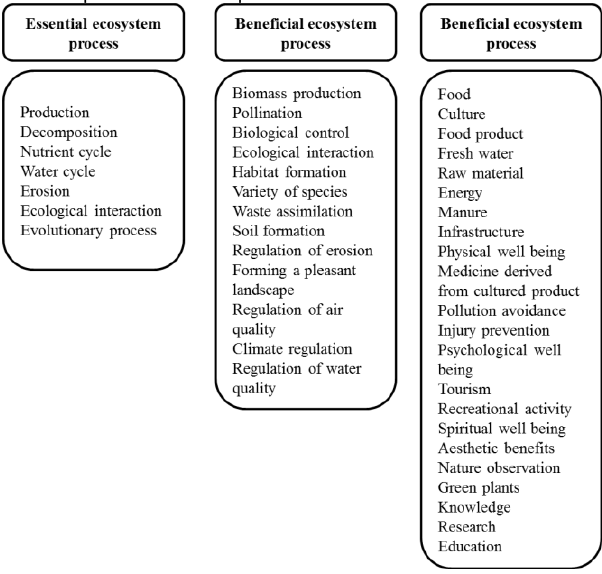
Fig. 6. Framework and typology proposed by Balmford et al (2008) (Source: Pesche and Méral,